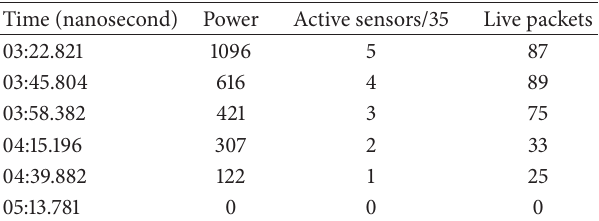
Table 4: Observed values in the last times of